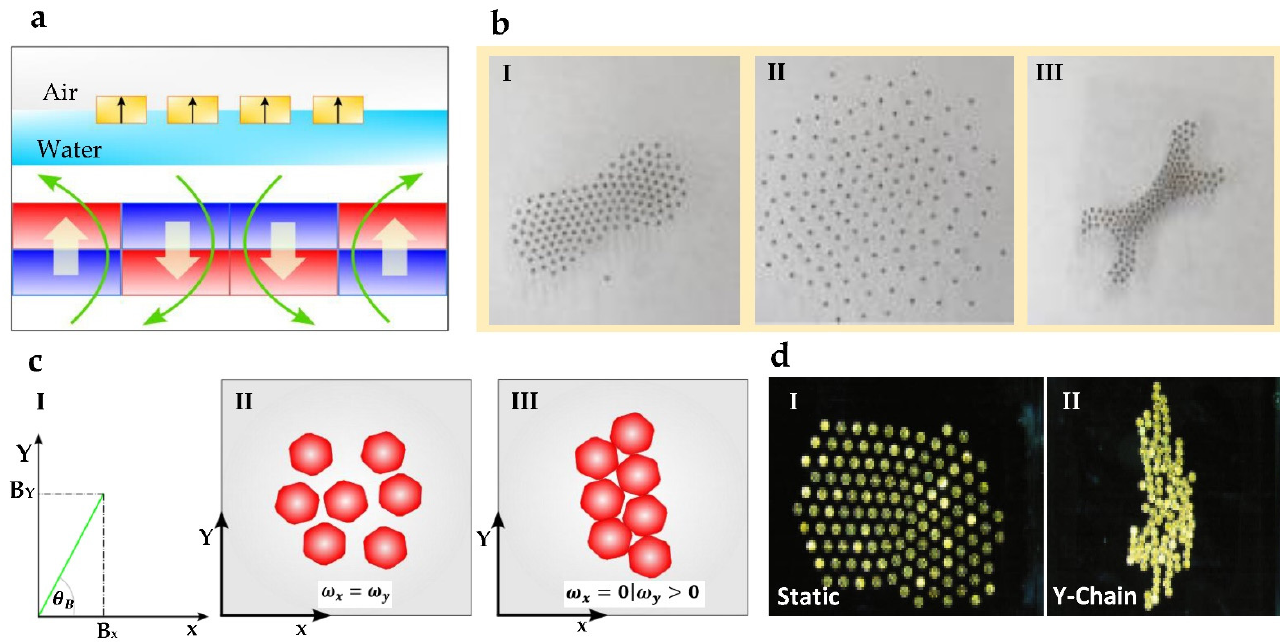
Figure 1. Shape formation techniques using magnetic fields: ( a ) Side view of programmable magnetic array that is used to change the resultant magnetic field on the air–water interface. ( b ) Representative example of microparticles aggregating to form the target formation under the resultant magnetic field generated by the magnetic array. Reproduced with permission from [40]; published by SAGE Publications. ( c ) The graph represents the resulting magnetic field from two orthogonal magnetic fields. The two figures show how microrobots form different formations when the applied magnetic field frequencies ( ω x , ω y ) are equal to or greater than the other. ( d ) Representative example of micro-disk formations into static (when ω x = ω y ) and Y-chain formations (when ω x = 0; ω y > 10) with magnetic field frequency variation. Reproduced with permission from [67]; published by Springer